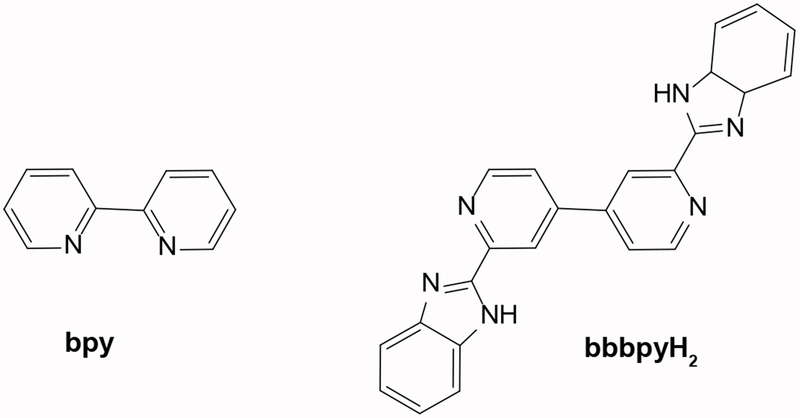
Schematic view of 2,2’-bipyridine (bpy) and bridging ligand 2,2′-bis(benzimidazol-2-yl)-4,4′-bipyridine (bbbpyH2).